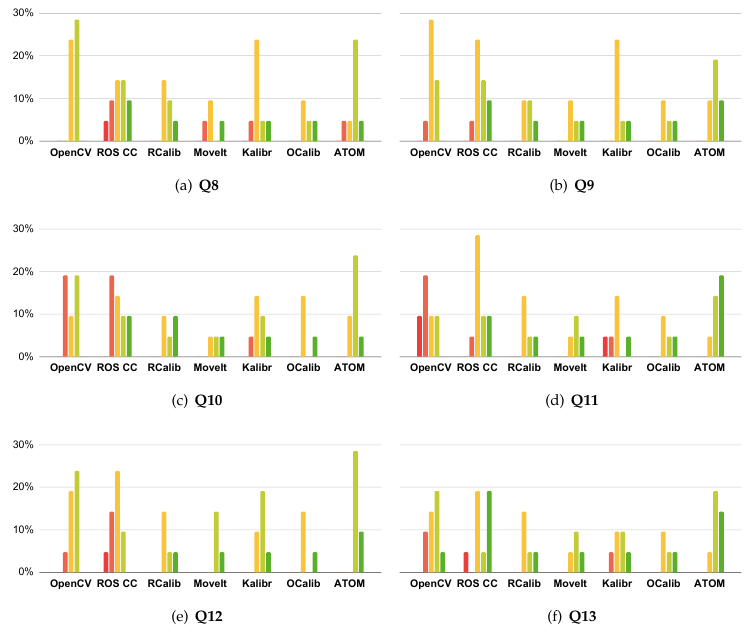
Figure 18. Responses to questions Q8-Q13 . Same scale as Figure 17. Q8 - It is easy to calibrate a system using this approach. Q9 - This approach is intuitive to use. Q10 - The calibration approach agree). Red represents 1, orange represents 2, yellow represents 3, light green represents 4 and green represents 5. Q8 —It is easy to calibrate a system using this approach. Q9 —This approach